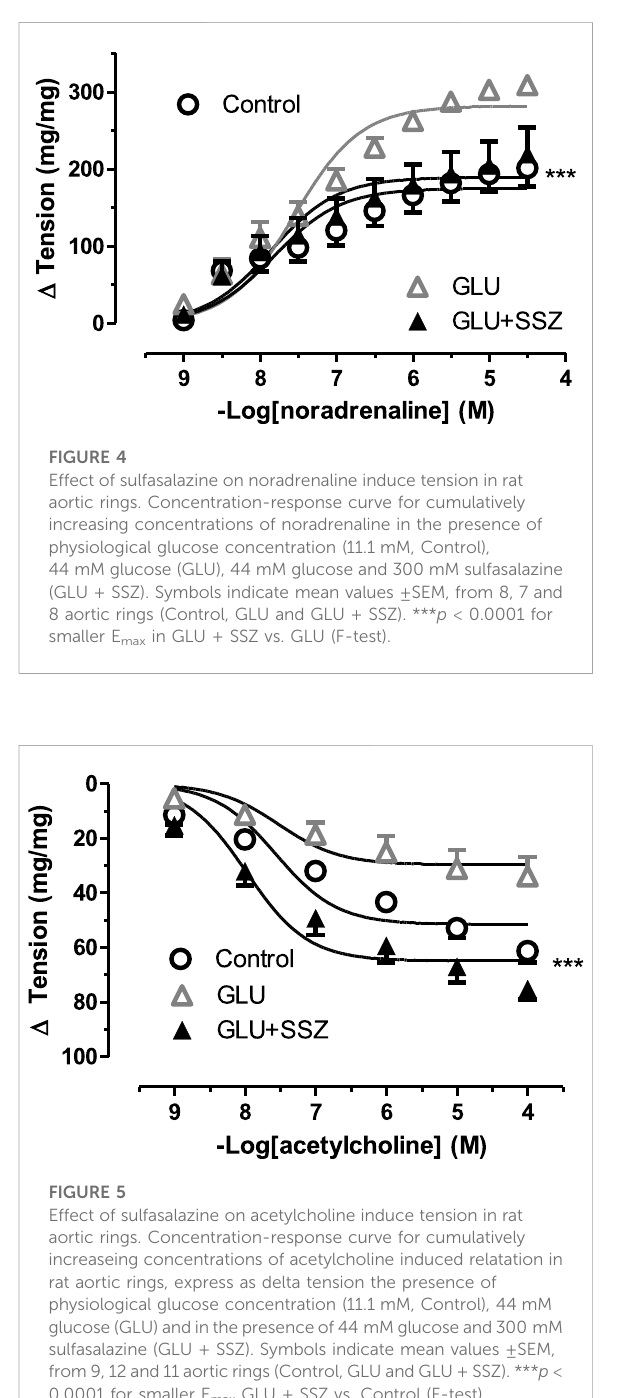
signi fi cant difference compared to the control group (Figure 4). Similarly, the E max value of the sulfasalazine group was signi fi cantly smaller than the GLU group. The pD 2 values of the sulfasalazine and the GLU groups were no signi fi cant difference (Supplementary Table S3).